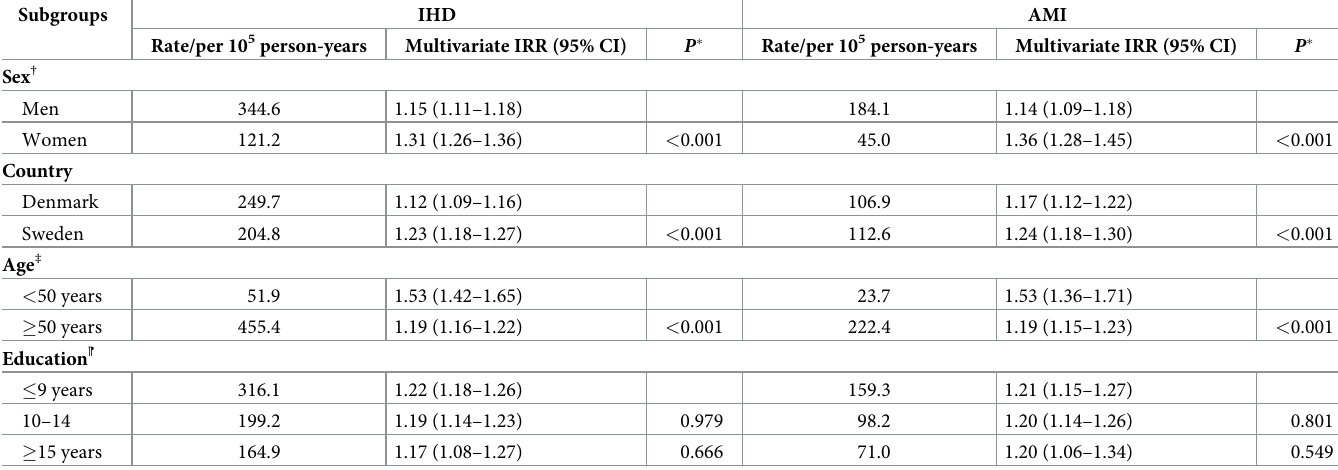
Table 3. Adjusted IRRs and 95% CIs for the association between the death of a child and the risk of IHD in stratified analyses.